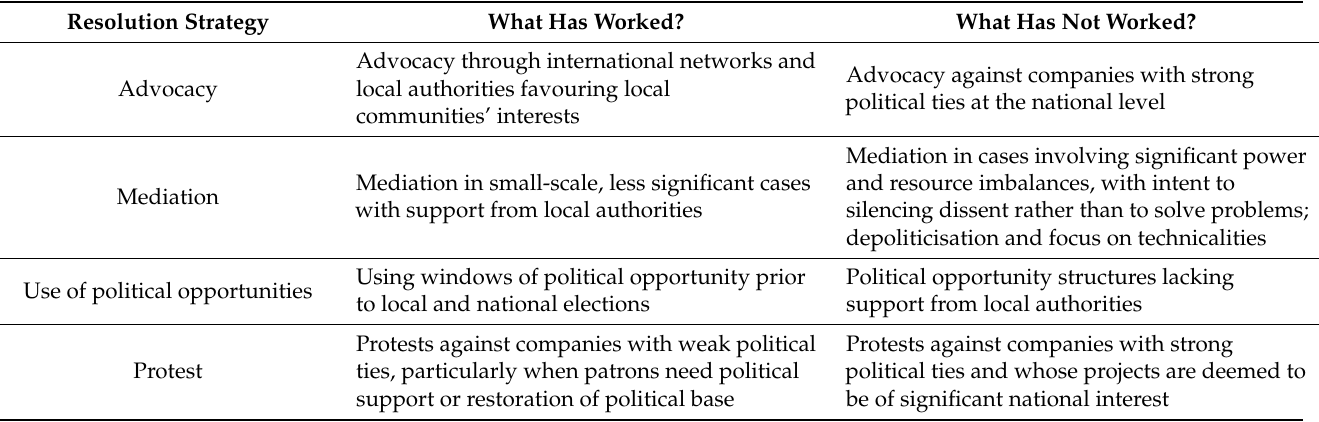
Table 2. Key factors influencing the outcomes of resolution strategies employed in land restitution processes in Cambodia. Resolution